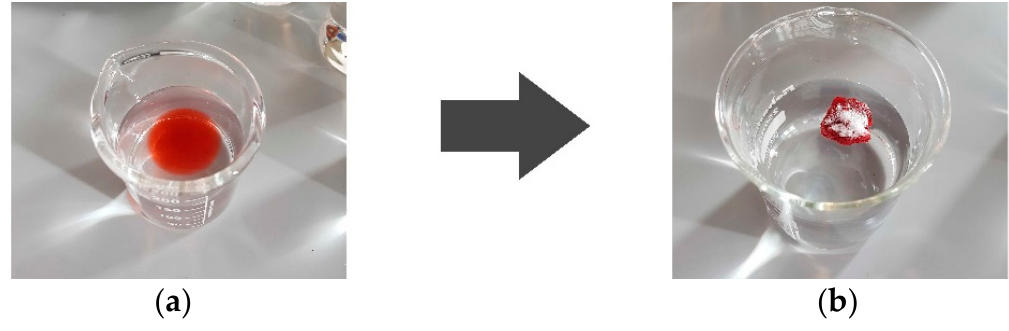
Figure 7. Selective adsorption schematic by sorbents. ( a ) Water and oil; ( b ) water oil and adsorbent filters.